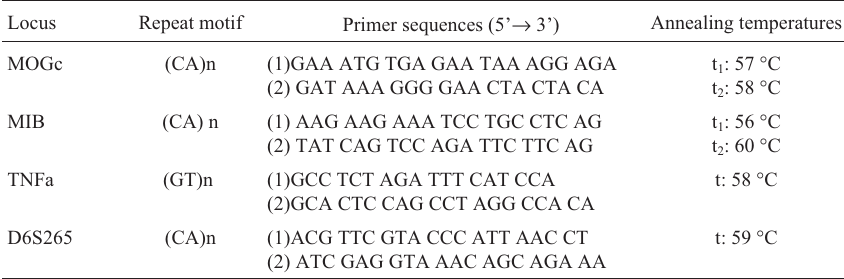
Table 1 - Characteristics of the microsatellites, primers employed and PCR